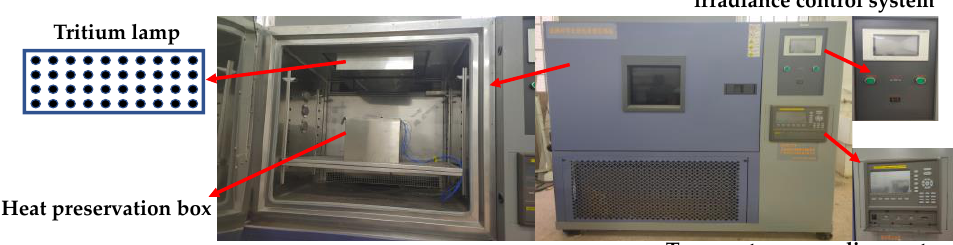
Figure 1. Ultraviolet (UV) environment simulation chamber and its components.